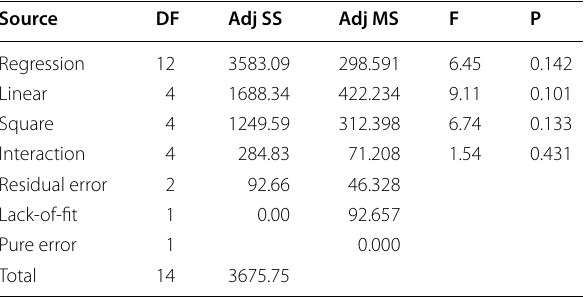
Table 3 Analysis of variance for xylonic acid production using C. glutamicum ATCC 31831